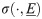
General shape of the function σ(⋅,E_).